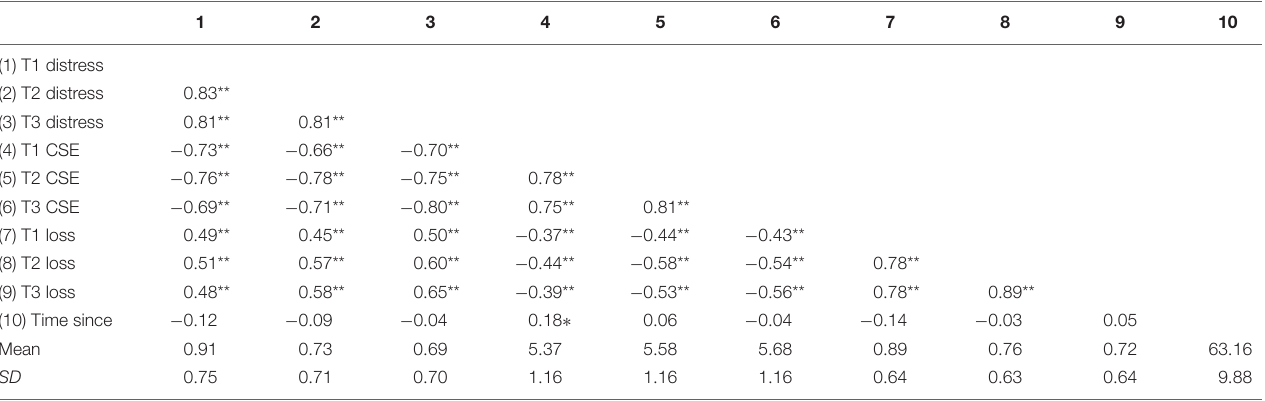
TABLE 1 | Pearson’s correlations, mean, and standard deviations of the study variables in Study 1.